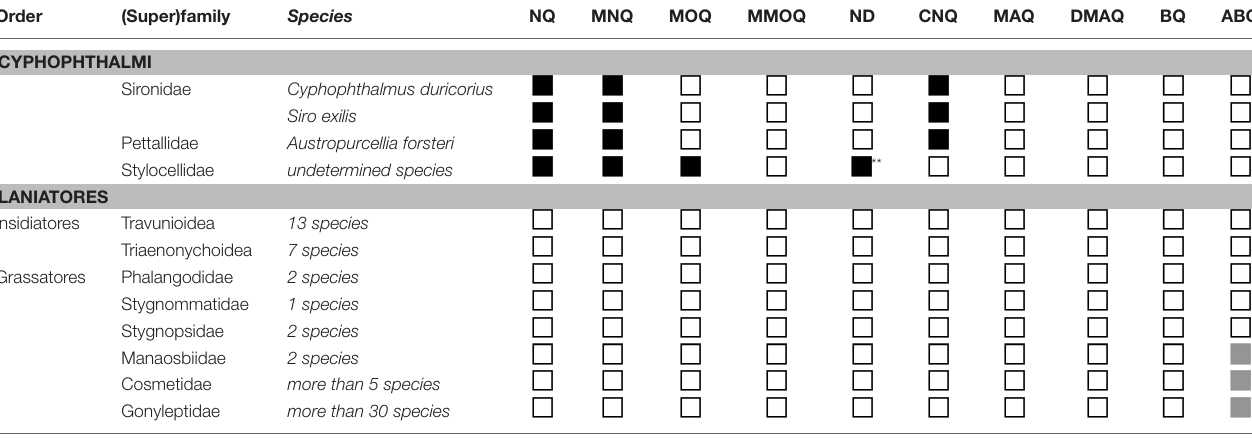
TABLE 4 | Naphtho- and benzoquinone distribution across Laniatores and Cyphophthalmi (metadata*).